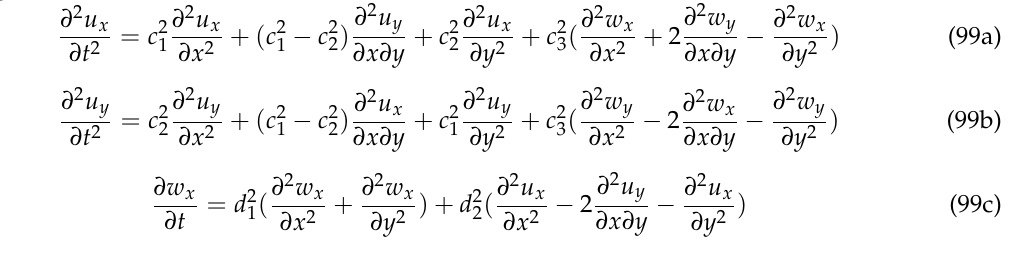
(cid:107) x / w b  = with x ( y = with ( 0.01 mm y 3 z